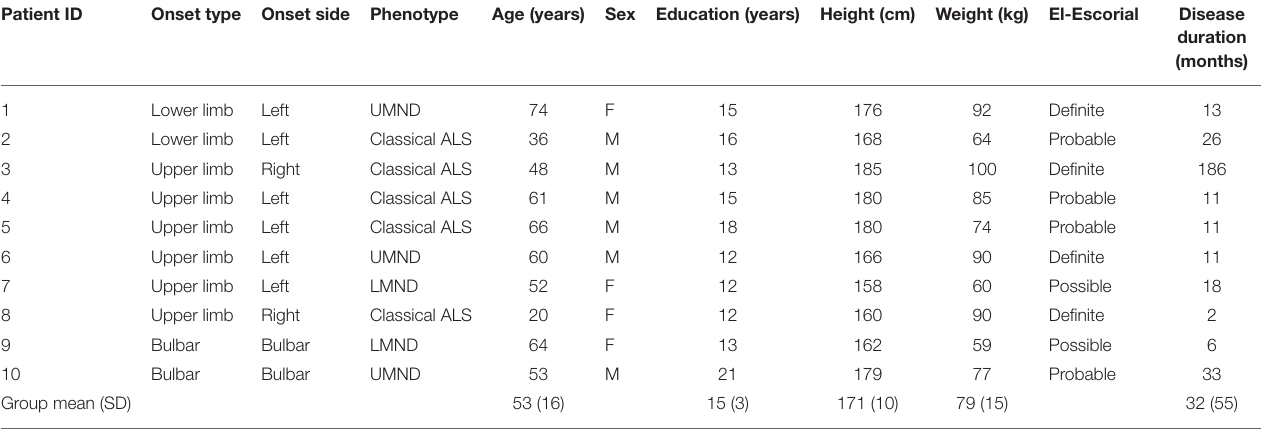
TABLE 2 | Demographic information for patients with ALS. Patient ID